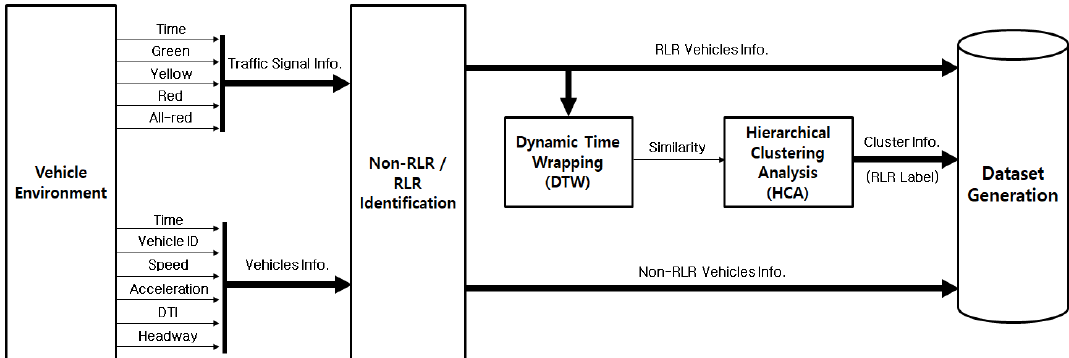
Figure 2. Dataset preparation process for